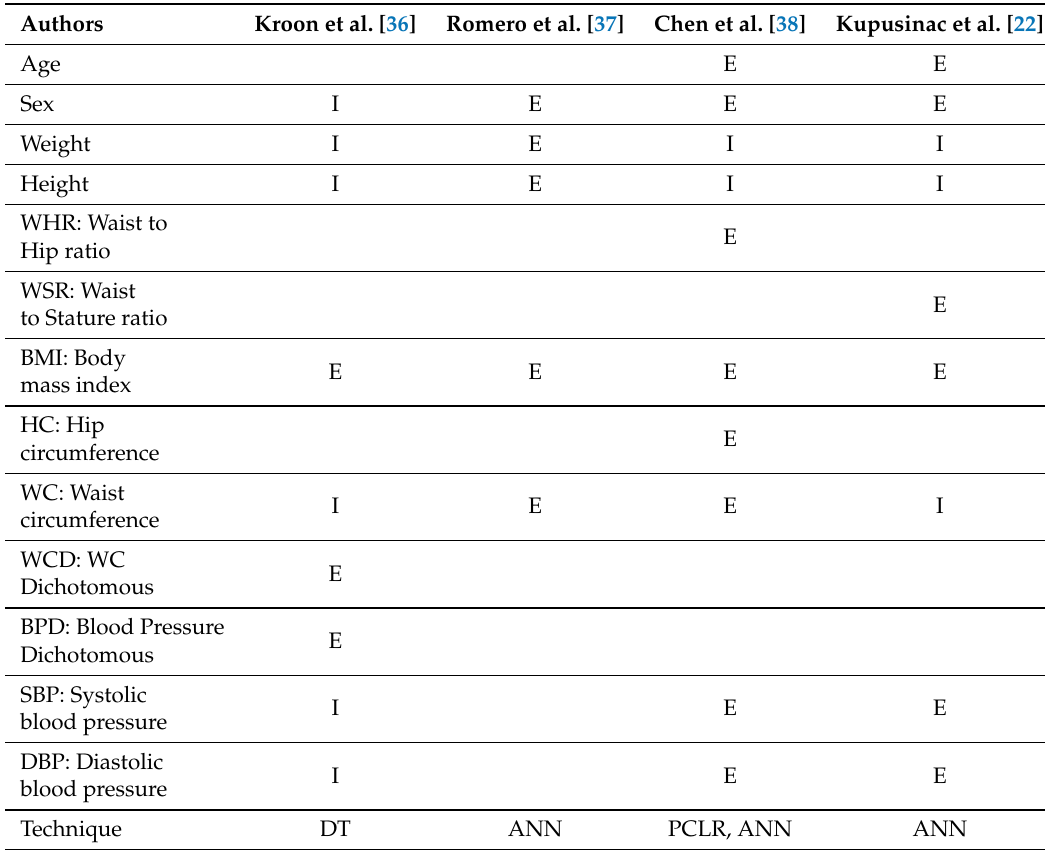
Table 3. Variables and technique used by the